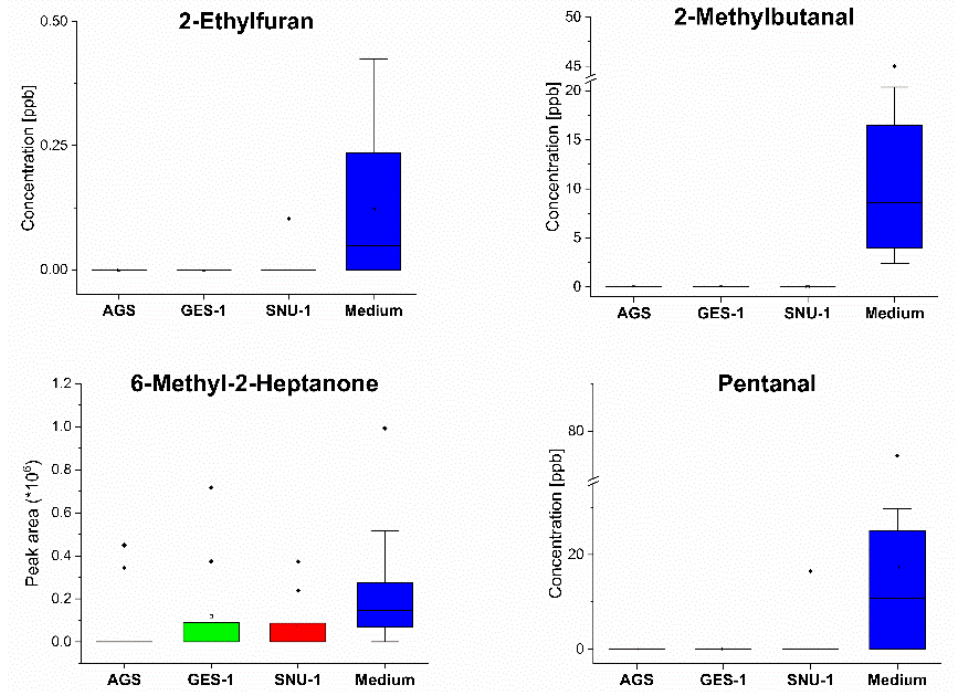
Figure 1. Comparison of the headspace concentrations of selected consumed VOCs over the cultures of AGS, SNU-1, GES-1 cells and medium. Red—cancer cells, green—normal cells, blue—medium.